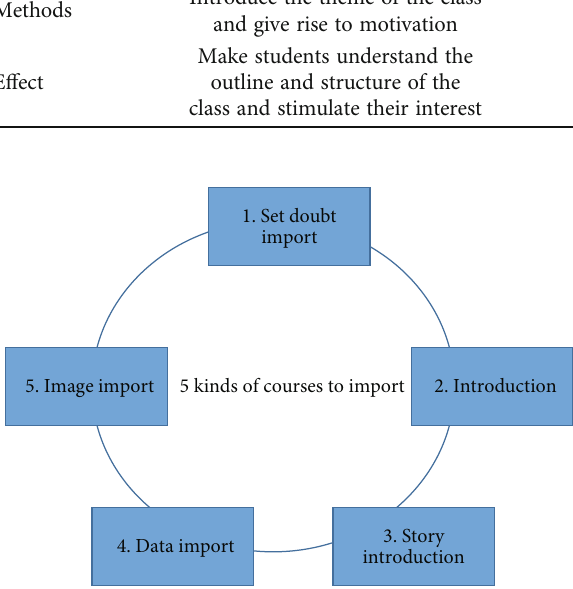
Figure 12: Available examples of import